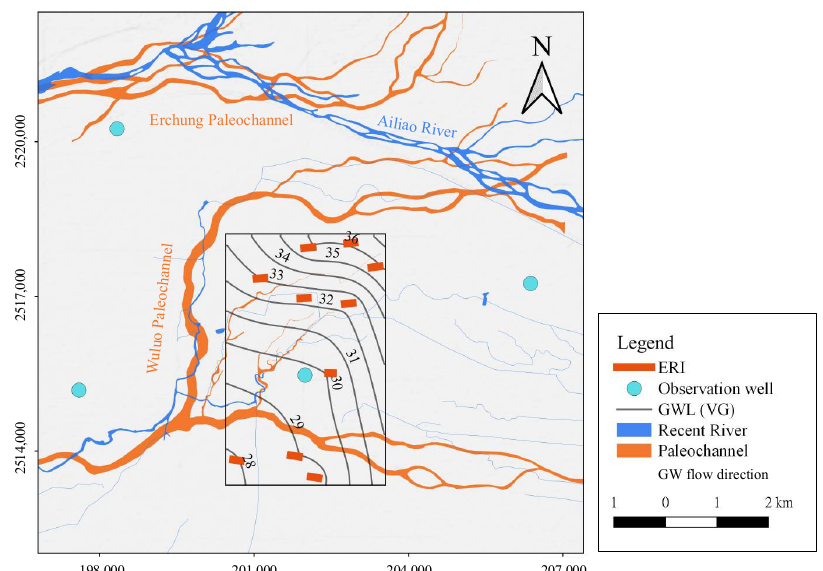
Figure 16. The distribution of the Groundwater Level (GWL) in wet season overlays the paleochannel map of the 1904 year.